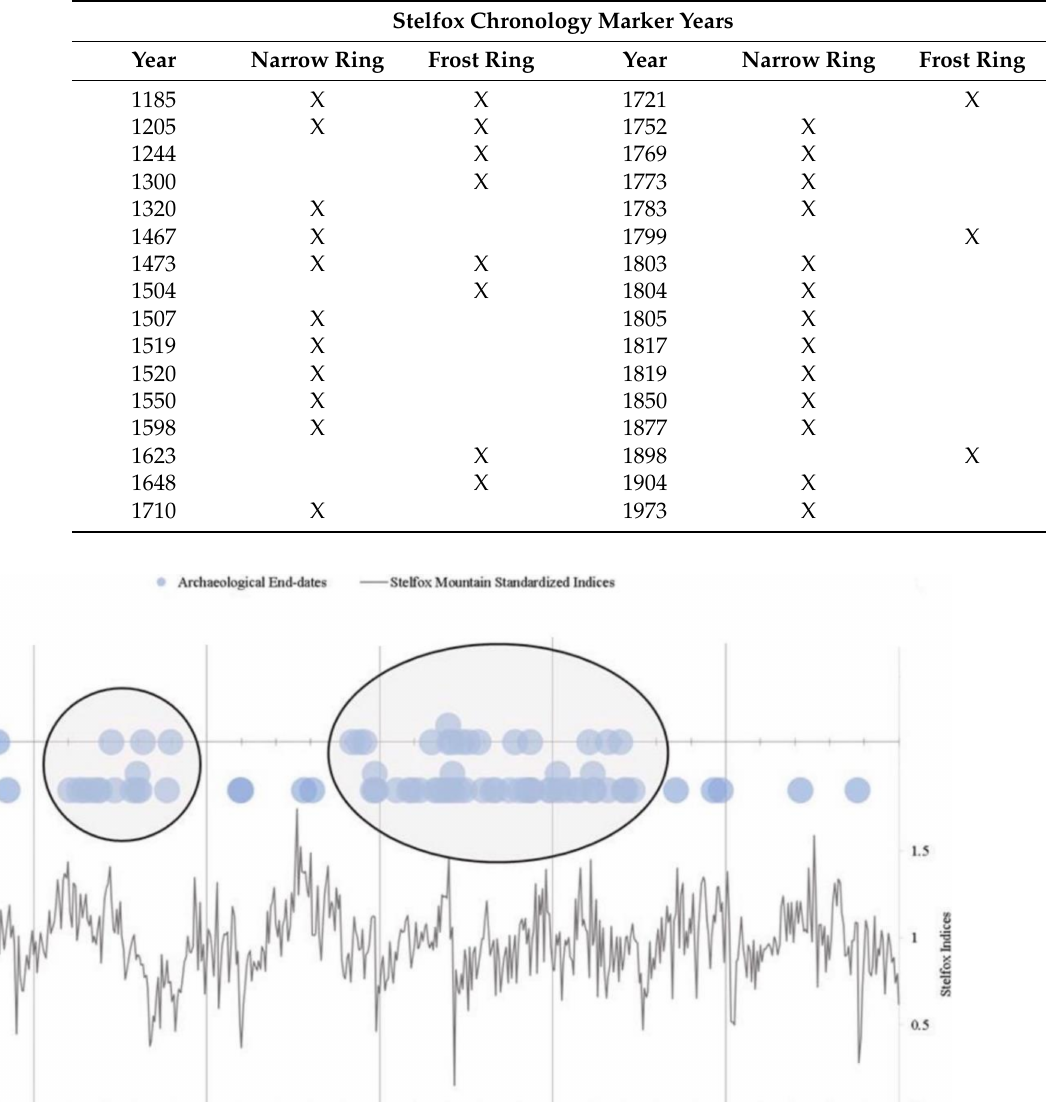
Table 2. Crossdating marker years that note years of statistically narrow radial growth. These marker rings were used to help establish the overall pattern of growth within the master chronology between the overlapping live, snag, and archaeological samples.